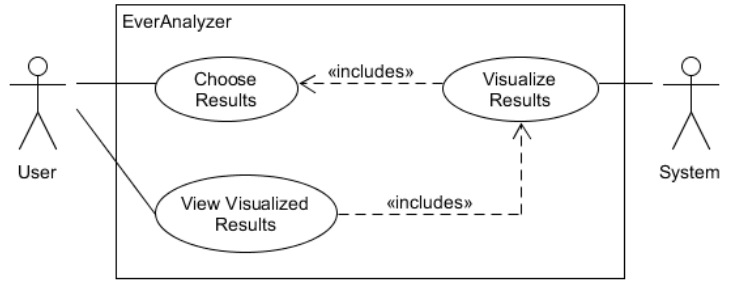
Figure 12. Use Case diagram of EverAnalyzer Objective #7.